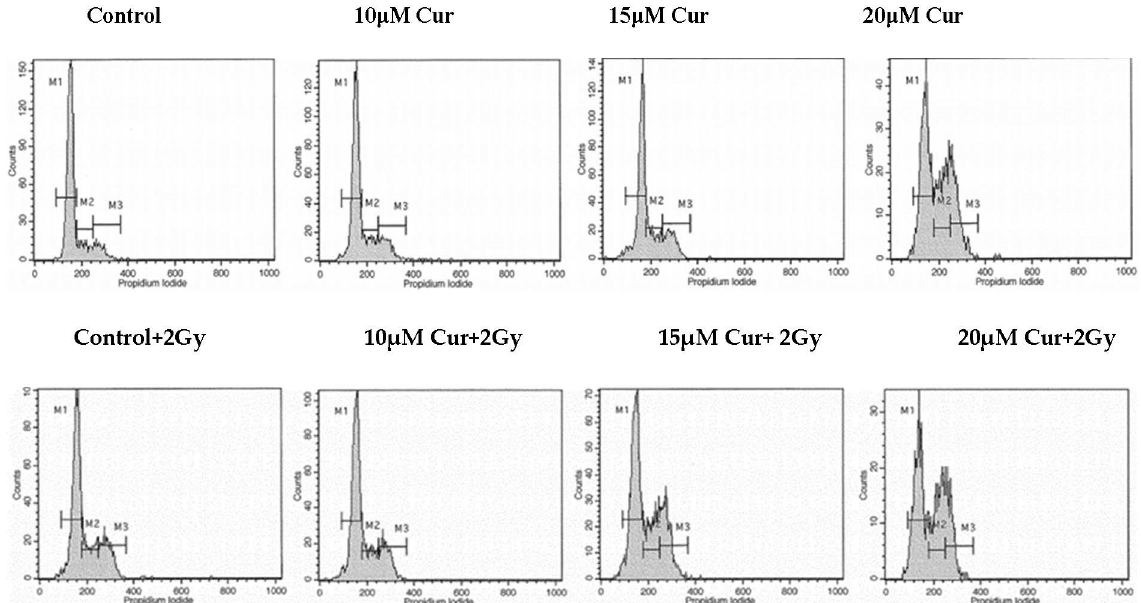
Figure 8. Histogram representation of cell-cycle distribution in T98 cells after treatment with increasing curcumin concen- trations. Following the same procedure, the cells were stained with propidium iodide at 72 h, and the DNA content was observed. Curcumin and radiation co-treatment induced G2/M arrest in glioblastoma cells. 2.4. Curcumin and Temozolomide Exhibited Synergistic Anti-Proliferative Effect on Glioma Cells